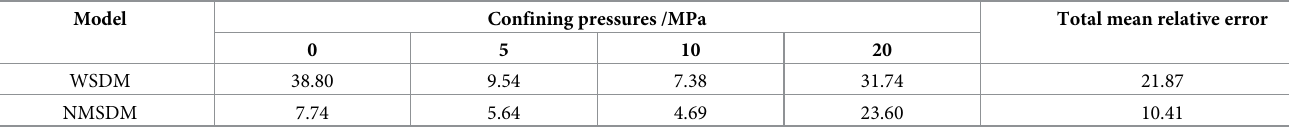
Table 3. Mean relative errors of theoretical models for sandstone (%).